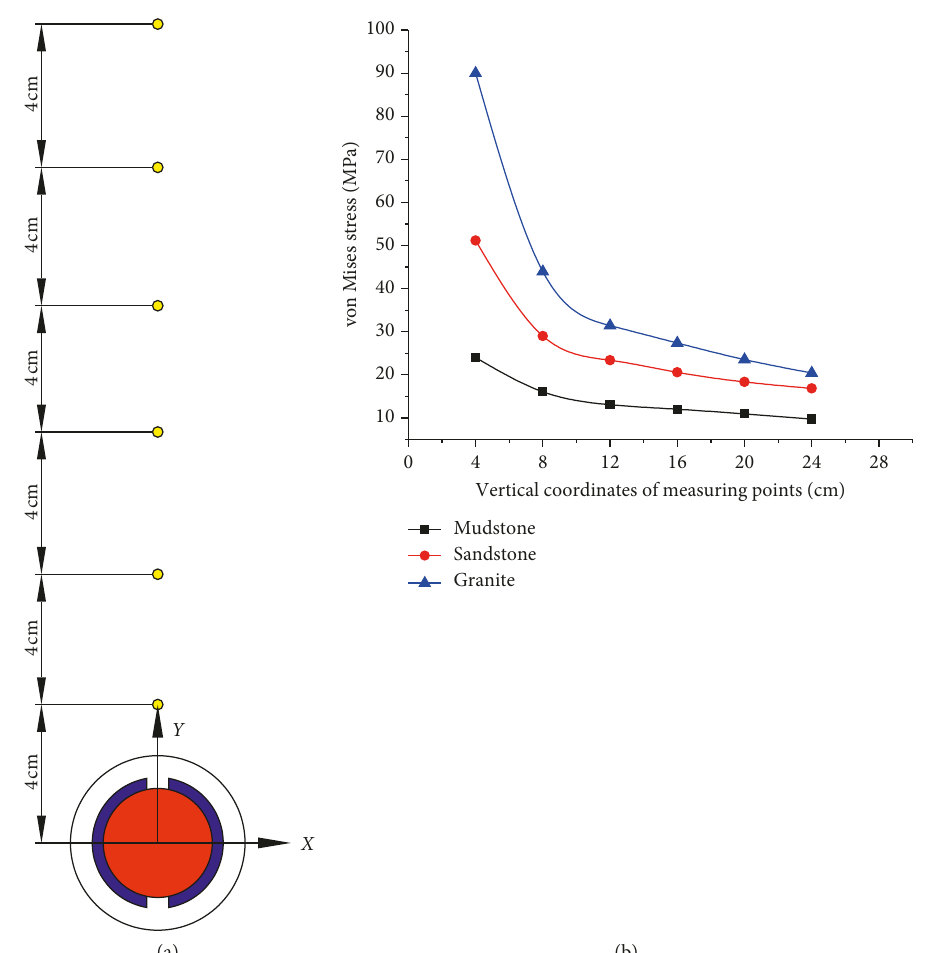
Figure 8: (a) Position of measuring points; (b) distribution of effective stress peaks in the slotted direction along the Y axis in